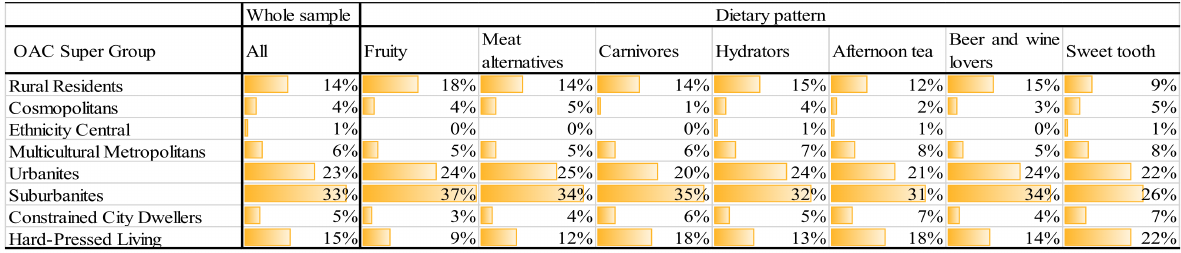
Figure 5. Distribution of groups of loyalty card holders amongst Output Area Classification (OAC) Super Groups. Table 1 provides a breakdown of the daily nutrient purchasing of each dietary